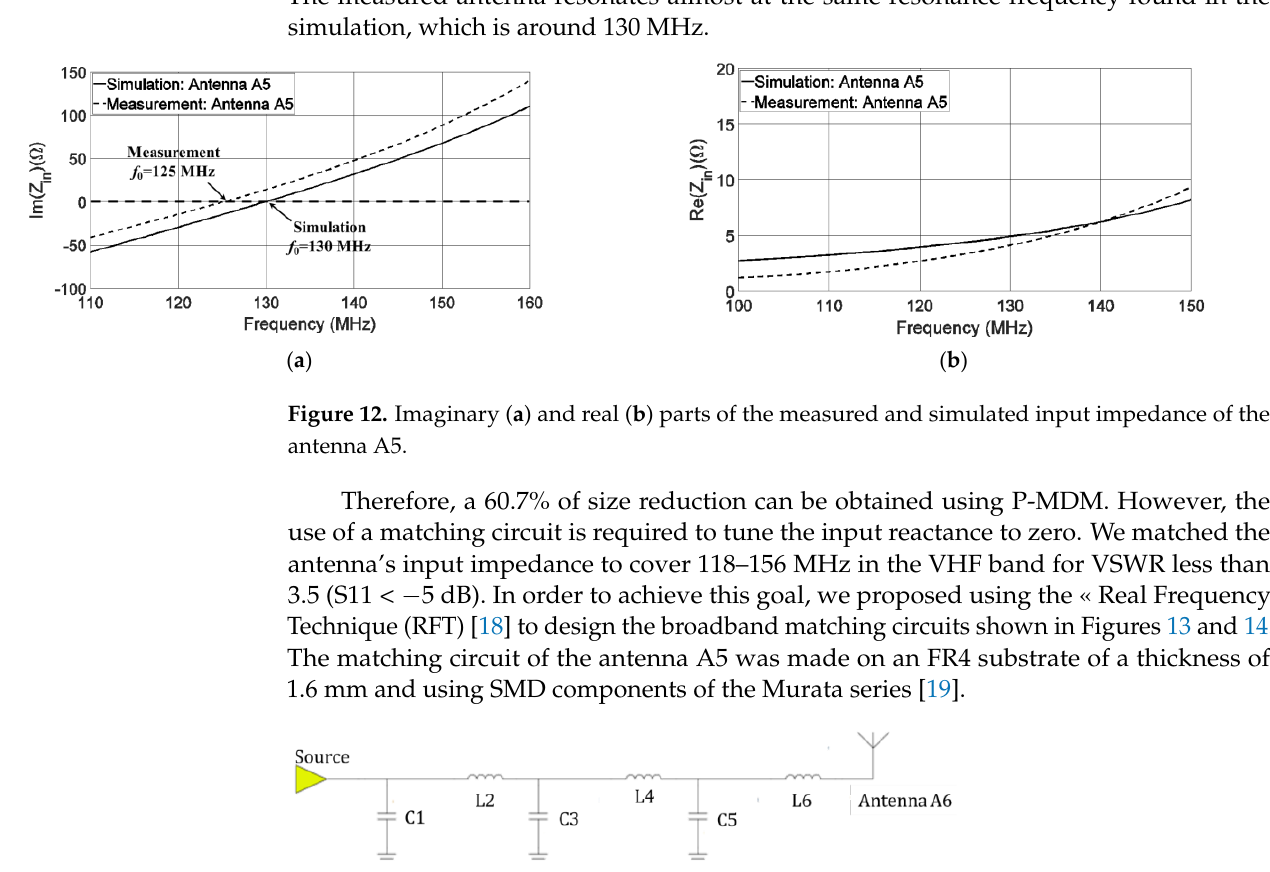
Figure 12. Imaginary ( a ) and real ( b ) parts of the measured and simulated input impedance of the antenna A5.